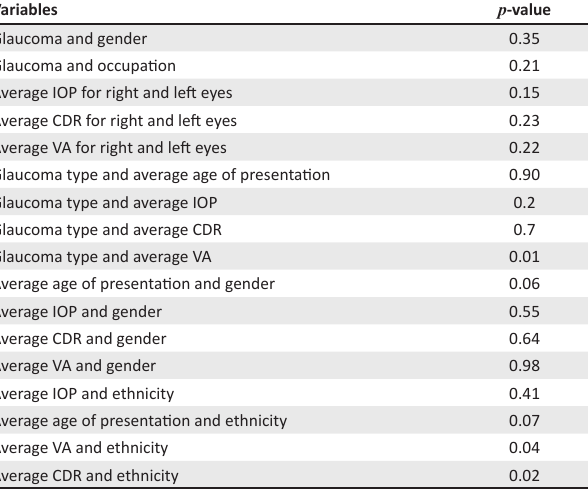
TABLE 6: List of probability values among different variables.